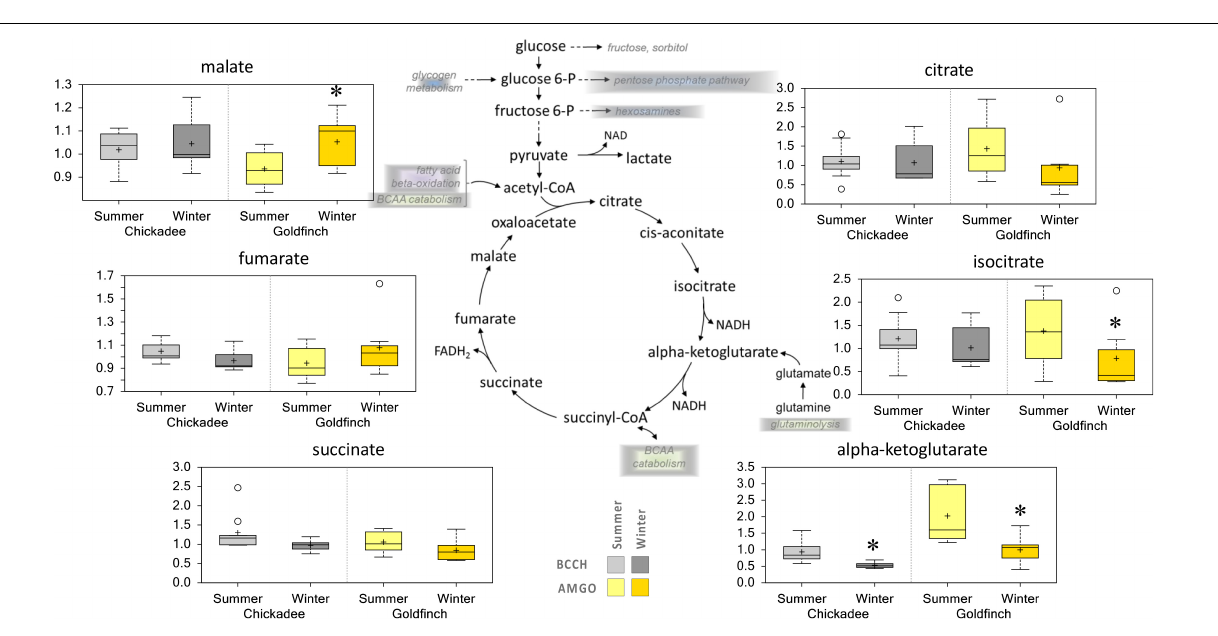
FIGURE 6 | Differences in the abundances of metabolites involved in TCA cycle metabolism in pectoralis muscle of Black-Capped Chickadee (BCCH) and American Goldfinch (AMGO). The X -axis represents the species and the seasons sampled. The Y -axis box plots indicate the scaled intensity mean (+) and median (-) values: upper and lower ranges of boxes indicate upper and lower quartiles, respectively; upper and lower whiskers indicate the maximum and minimum distributions of the data; small circles represent outlying data points. ∗ Significantly ( p < 0.05 and q < 0.10) different compared to the other season within the